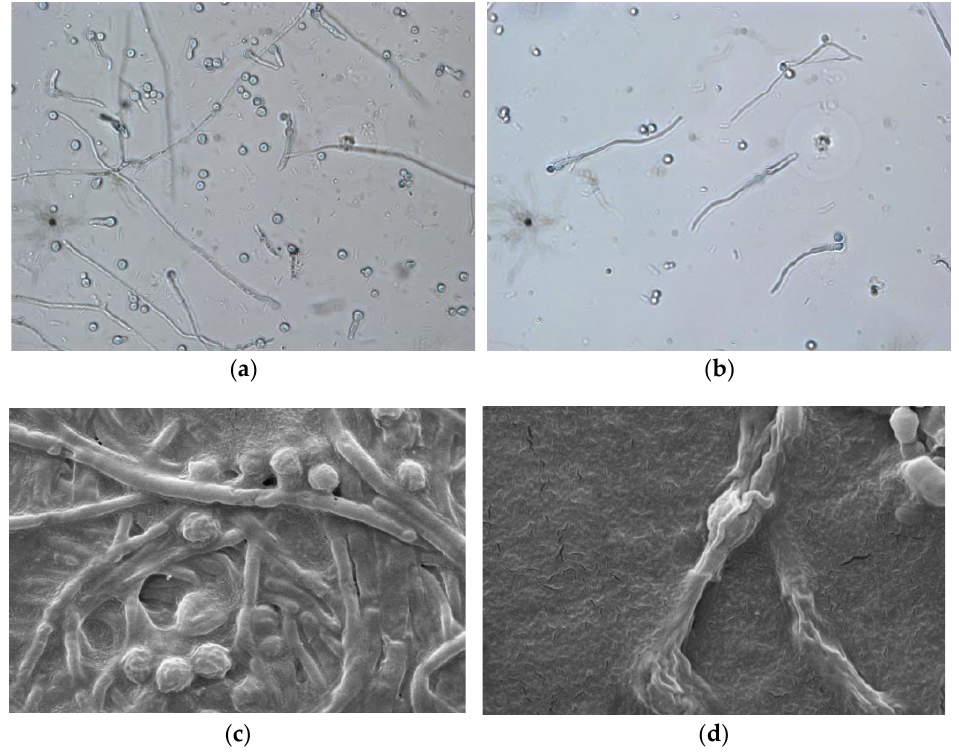
Figure 4. ( a ) Control of F. oxysporum in apotome microscopy observation 400 M; ( b ) F. oxysporum treated with crude C38BK2FA extract observed under apotome microscopy 400 M; ( c ) control of F. oxysporum observed using SEM 10 K x; ( d ) F. oxysporum treated with crude C38BK2FA extract observed using SEM 15 K x.